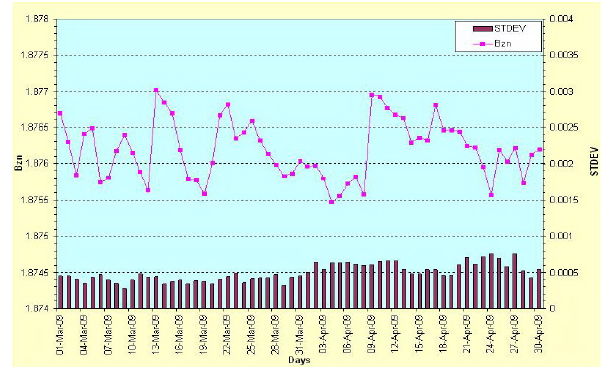
Fig. 10. Distribution of the Bzn and STDEV at NGOS on the inter- val 1 March–30 April 2009.